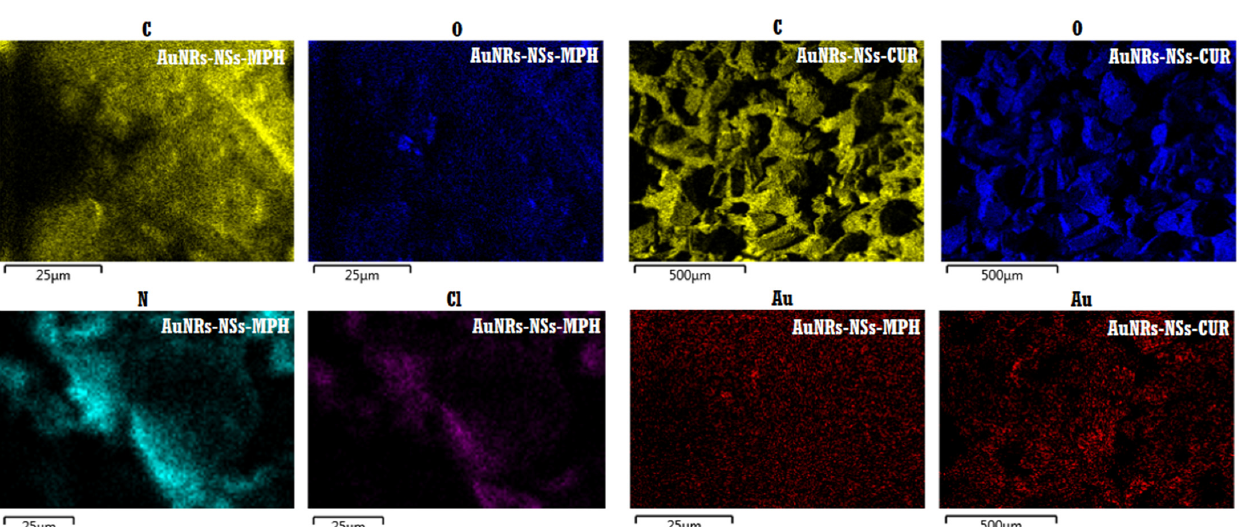
Figure 13. EDS mapping analyses of AuNRs-NSs–MPH and AuNRs-NSs–CUR.